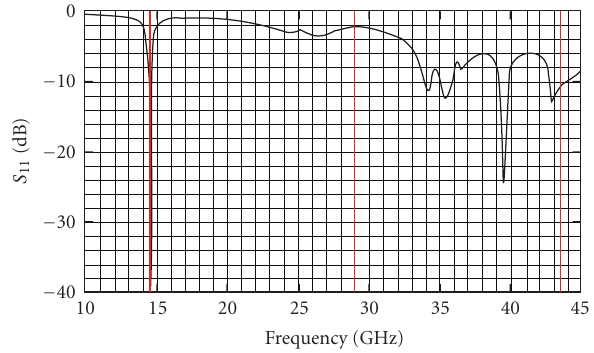
Figure 8: Return loss of the modified structure with two additional parallel slots as sketched in Figure